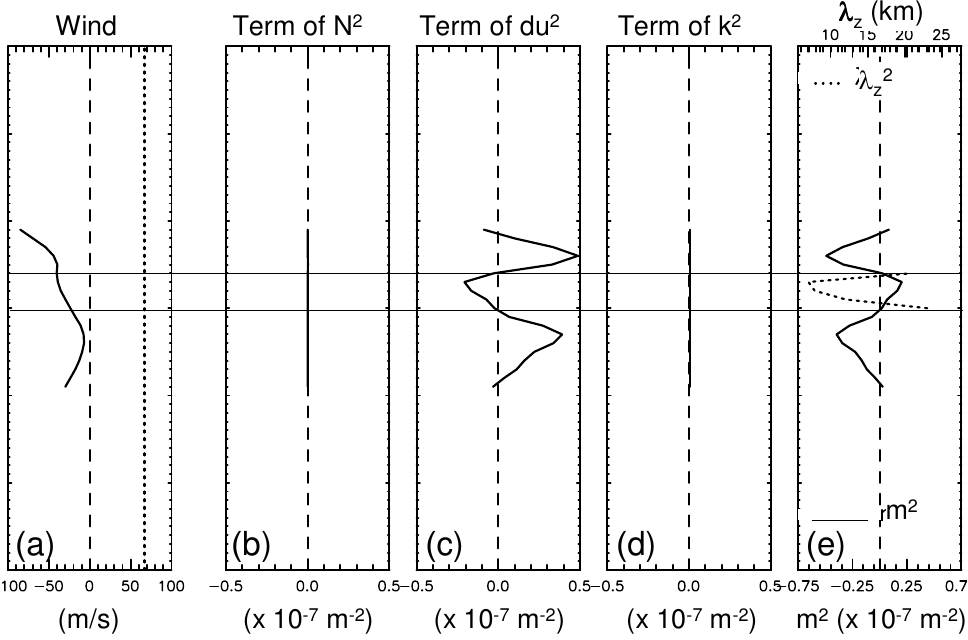
Fig. 3. Analysis of the m 2 terms calculated from wind and temperature data for mesospheric bore observed on 1 October 2005, over S˜ao Jo˜ao do